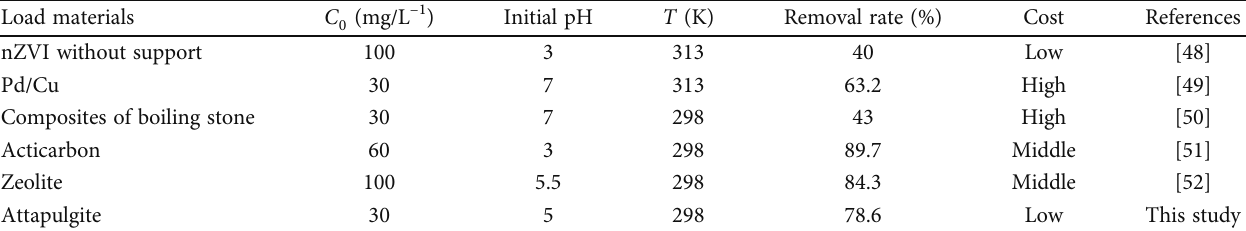
Table 1: Comparison of NO -N removal by various loaded nano-zero-valent iron 3